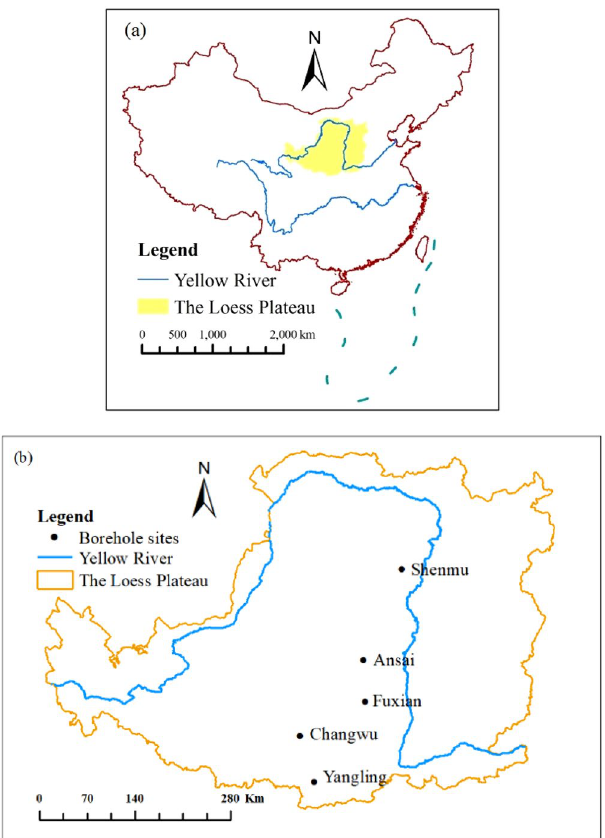
Figure 1. Locations of the Loess Plateau region in China ( a ) and the sampling sites ( b ); image data processed by ArcGIS 10.5 http://devel opers .arcgi